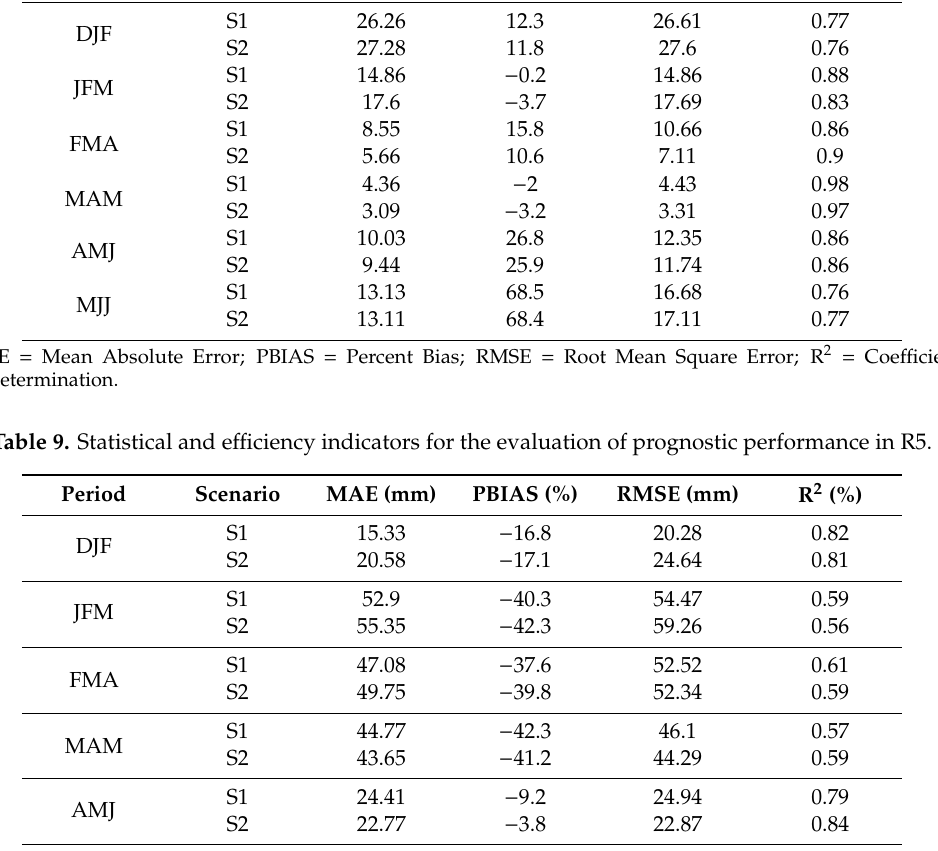
Table 8. Statistical and e ffi ciency indicators for the evaluation of prognostic performance in R4. Period Scenario